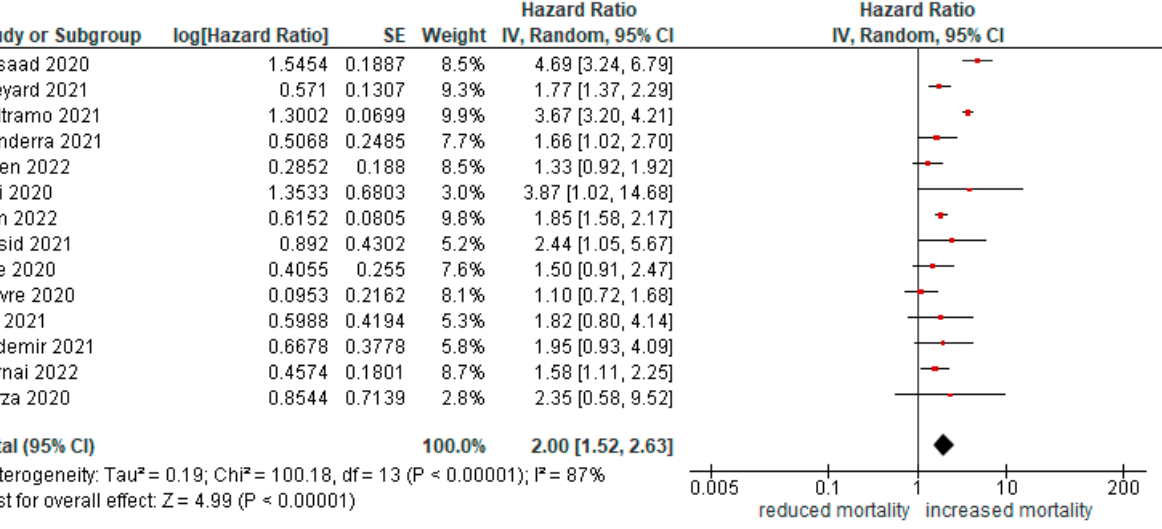
Figure 4. Forest plot for risk of mortality in lung cancer patients.